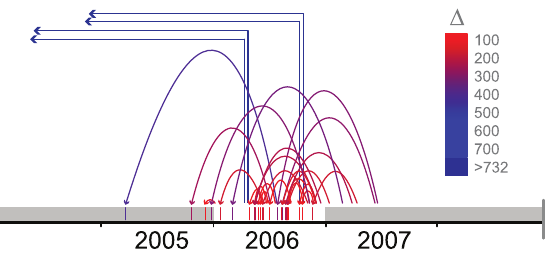
Figure 4. Example from the reevaluation of Swedish IDU surveillance data. Vertical bars of the rug represent inferred date of infection after model application. The maximal time shift, 6 732 days, implied by our SAR based predictive upper time-level (711 days) plus average time from infection to seroconversion (21 days) is indicated by grey zones before and after year 2006. The arrows show the resulting shift, starting at the time of diagnosis and pointing at the inferred date of infection, colored according to the time difference D .